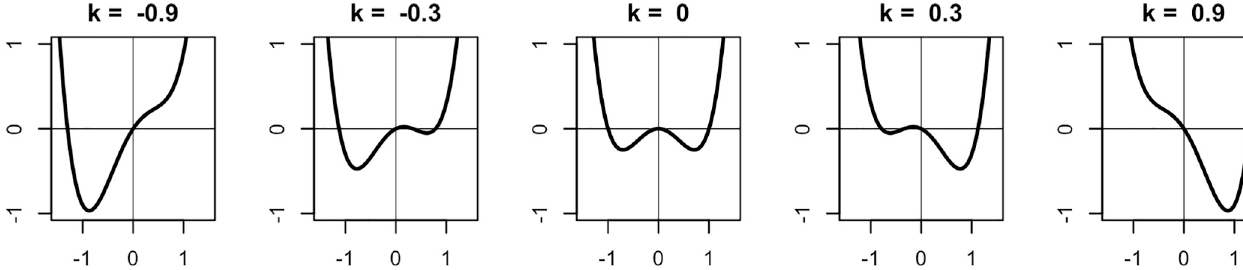
Fig 6. Attractor landscapes for the same system with different values for the parameter